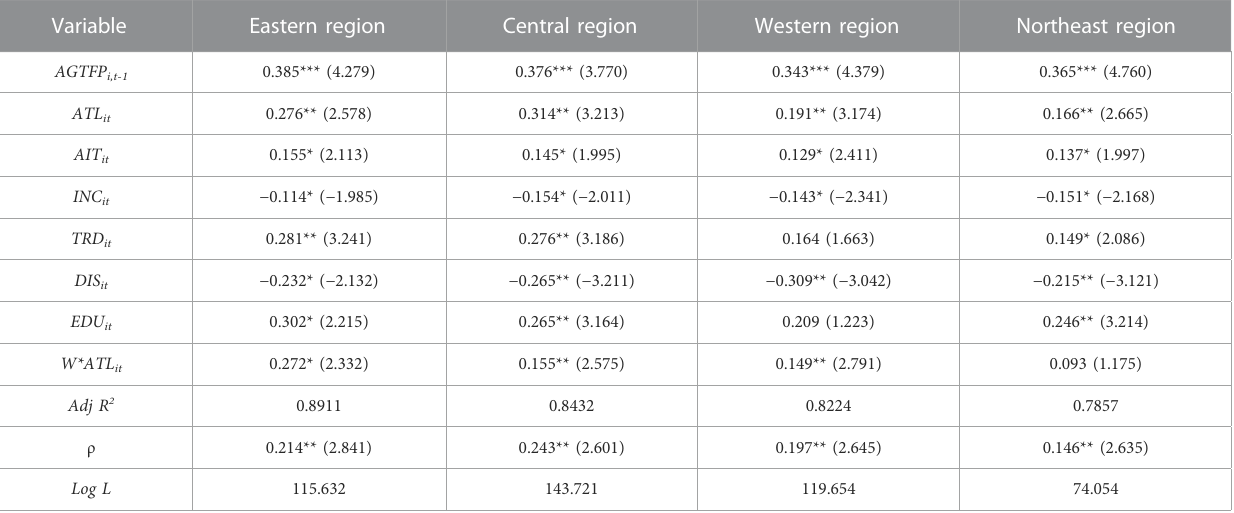
TABLE 10 Estimated results of different